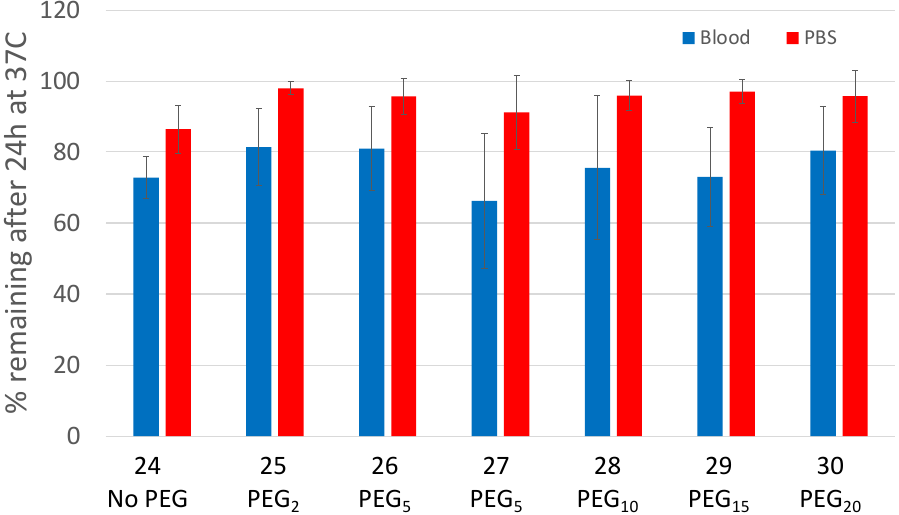
Figure 3. Stability of non-PEGylated and PEGylated [ 111 In]-DTPA-[ 2 Lys( D -biotin)]A20FMDV2 ana- logues ( 24 – 30 ) in human plasma. Data expressed as the amount of intact peptide relative to the input at time zero.